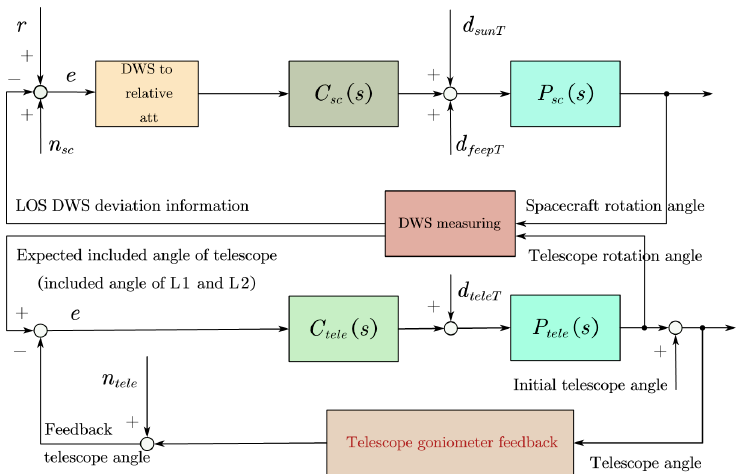
Figure 2. LOS tracking control mechanism. The attitudes of the spacecraft and the telescope are jointly adjusted to track the LOS. Among them, r , e , n sc , n tele , d sunT , d feepT , and d teleT represent the reference input, error, spacecraft attitude measurement noise, telescope angle measuring mechanism noise, spacecraft actuator noise, solar pressure noise, and telescope attitude actuator noise, respectively. C sc ( s ) , C tele ( s ) , P sc ( s ) , and P tele ( s ) represent the spacecraft attitude controller, telescope attitude controller, spacecraft plant, and telescope plant,